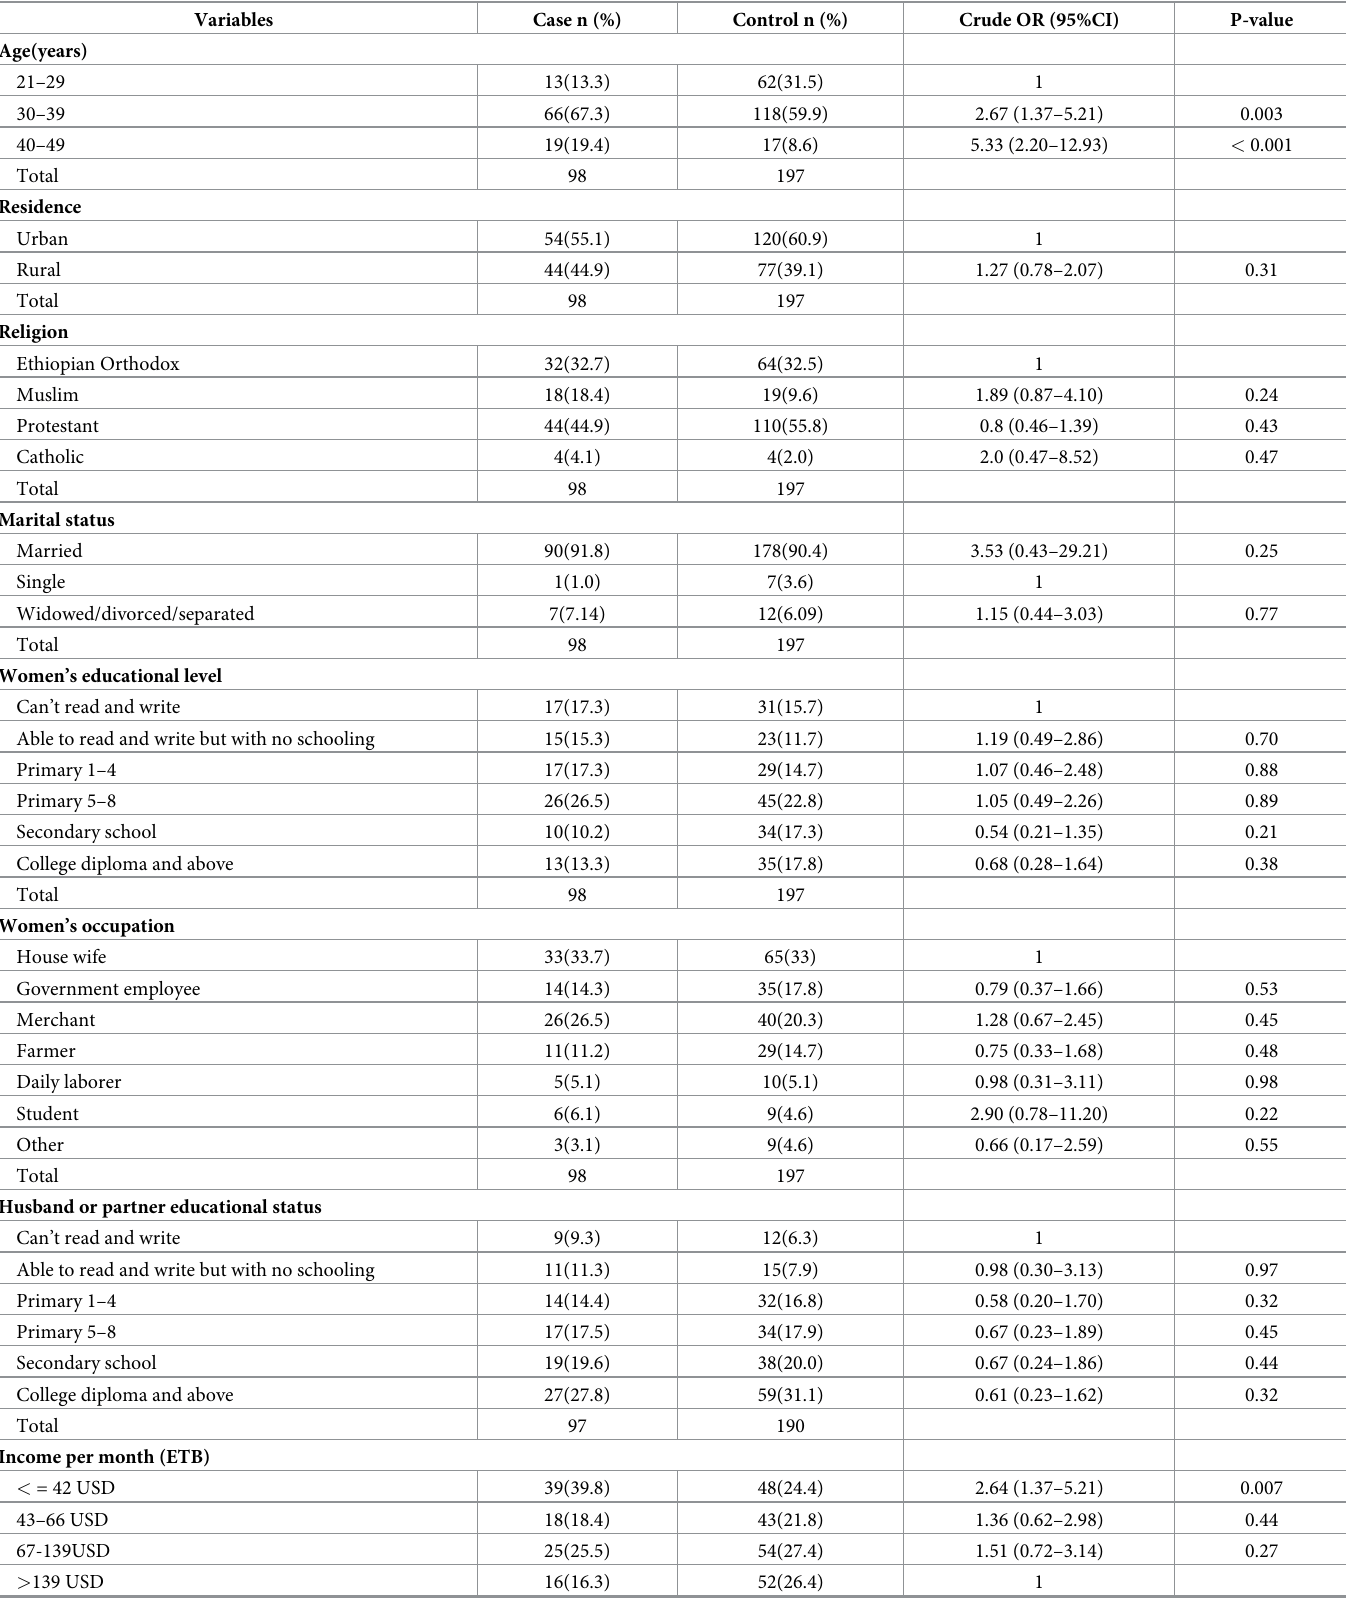
Table 1. Socio-demographic characteristics of women screened for cervical cancer in south Ethiopia,